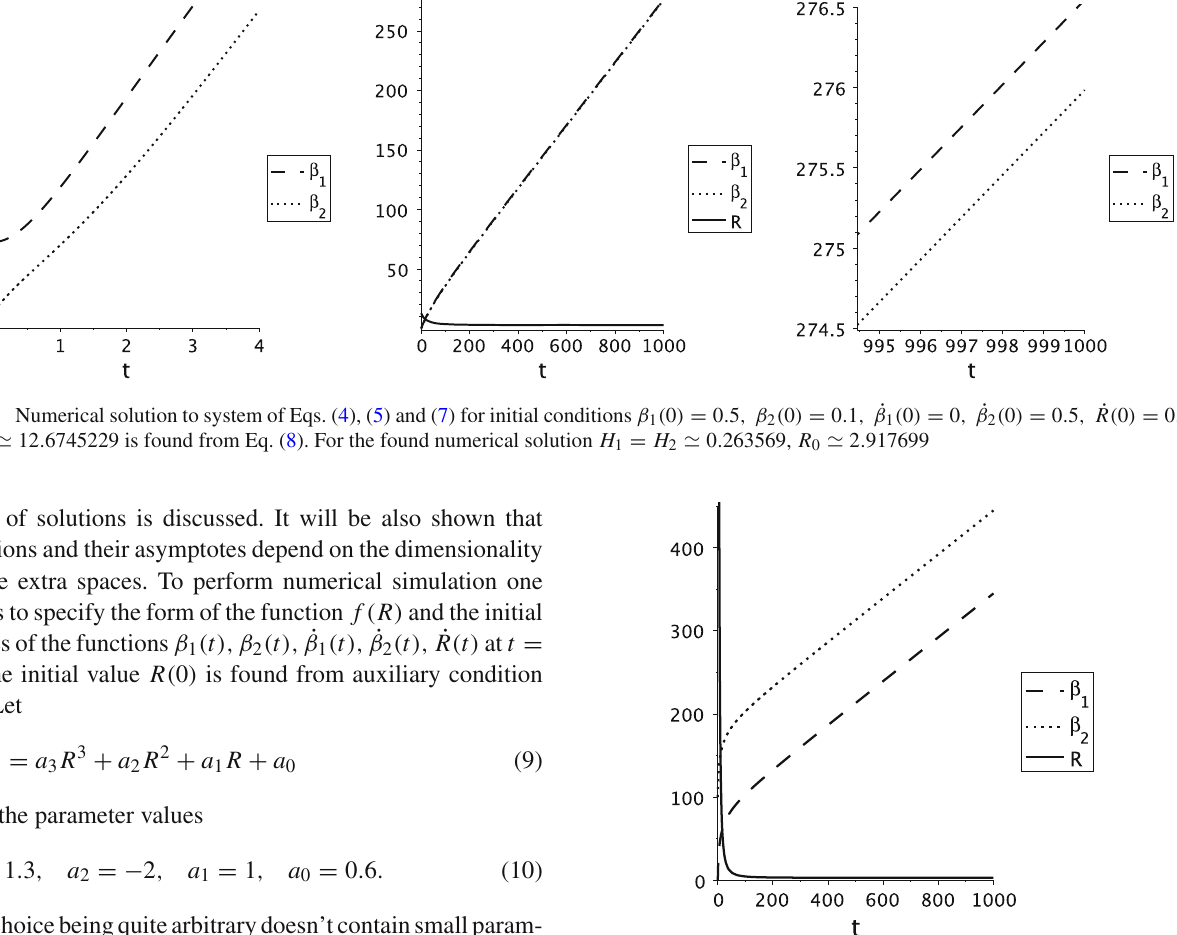
Fig. 2 Numerical solution to system of Eqs. (4), (5) and (7) for ini- tial conditions β 1 ( 0 ) = 0 . 5 , β 2 ( 0 ) = 100 , ˙ β 1 ( 0 ) = 0 , ˙ β 2 ( 0 ) = 50 , ˙ R ( 0 ) = 0. R ( 0 ) (cid:4) 22503 . 0545 is found from Eq.